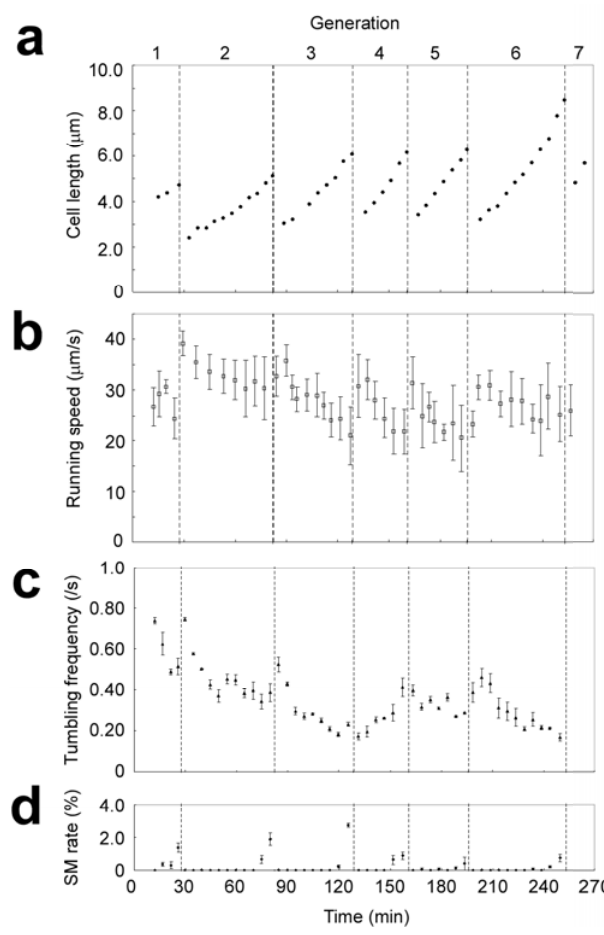
Vertical dashed lines correspond to the timing of cell divisions. ( d ) Prolonged pausing in a time window of 1 min and plotted as a function of time for the generations 2 through 6 with the timing of cell division (vertical solid lines) as well as the initiation of cell constriction (vertical dashed lines). Compared to the mean values before constriction (horizontal solid lines, mean; horizontal dashed lines, S.D.), the duration tended to increase in the final stage of cell